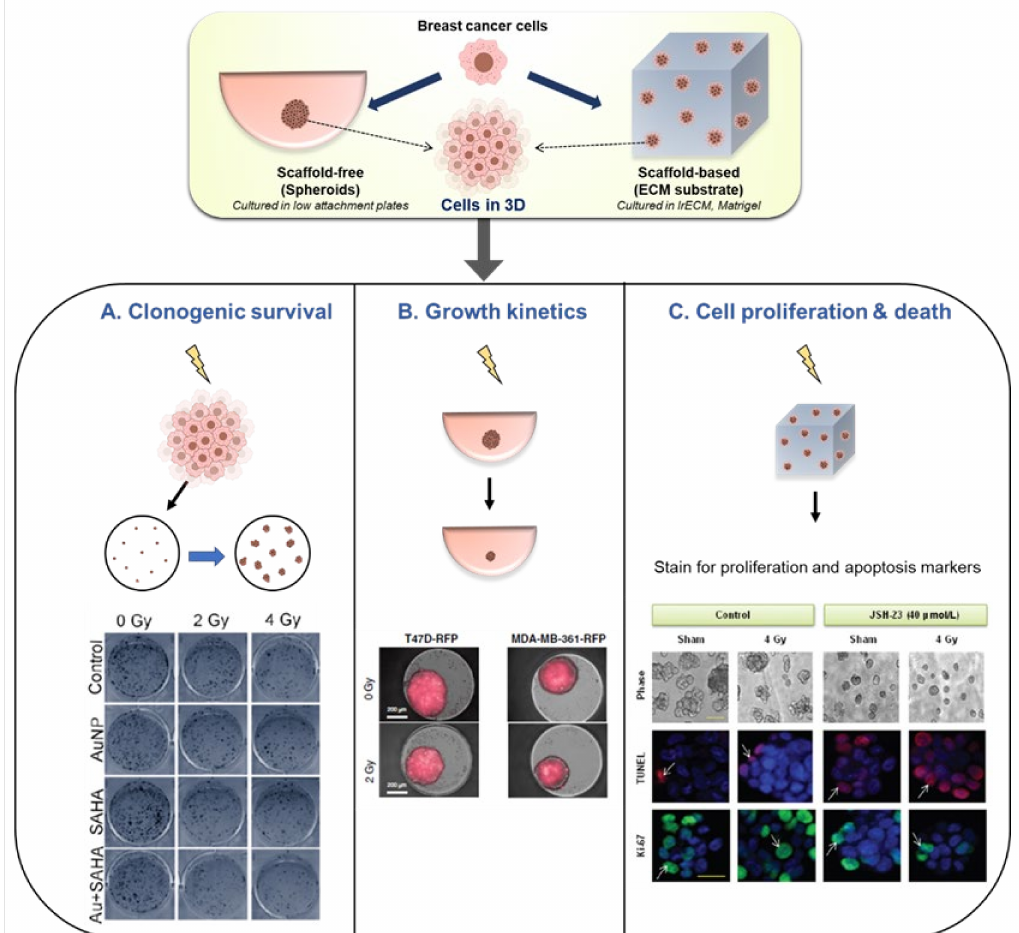
Figure 2. Analysis methods in radiobiology models of 3D breast cancer tissues. Spheroid (scaffold-free)-based and substrate- based cultures have been used to study in vitro radiation response in breast cancer cells. Some representative studies along with their methods of analysis of radiation effects are presented here. ( A ) Clonogenic survival assay: Cells are irradiated in 3D, then they are isolated and replated in 2D at low densities to assess their colony formation abilities. Evaluation of colony forming ability of irradiated MCF7 spheroids (reproduced from [109]). ( B ) Growth Kinetics: Spheroid cultures are irradiated and the effect on cell growth is identified by measuring changes in spheroid size. Evaluation of growth of breast cancer spheroids by measuring tissue area using constitutive lentiviral-RFP expression (reproduced from [107]). ( C ) Cell proliferation and death: Evaluation of radiation induced cell death and decrease in proliferation in T4-2 cells in laminin rich ECM cultures (reproduced from